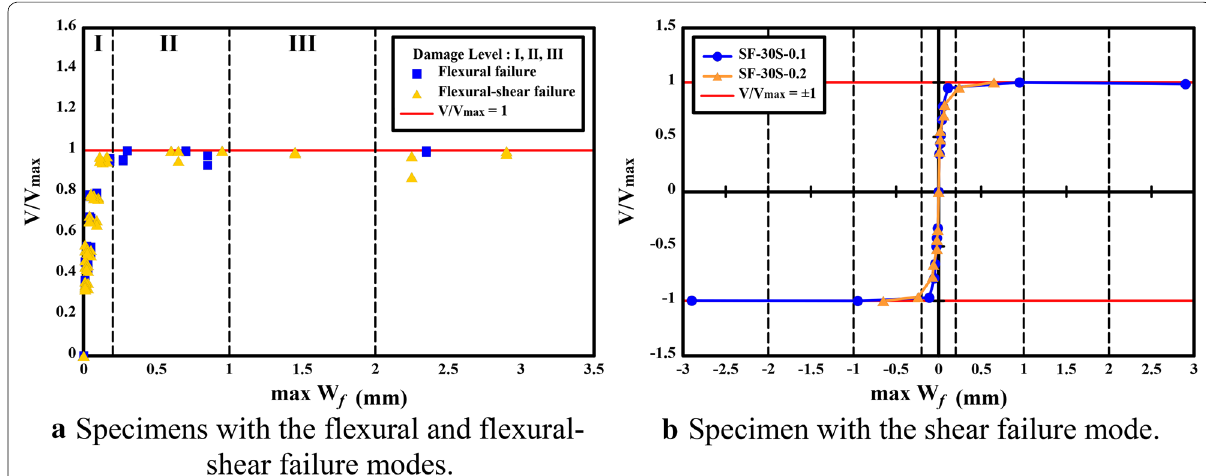
The value in the parentheses represent experimental reduction factors.